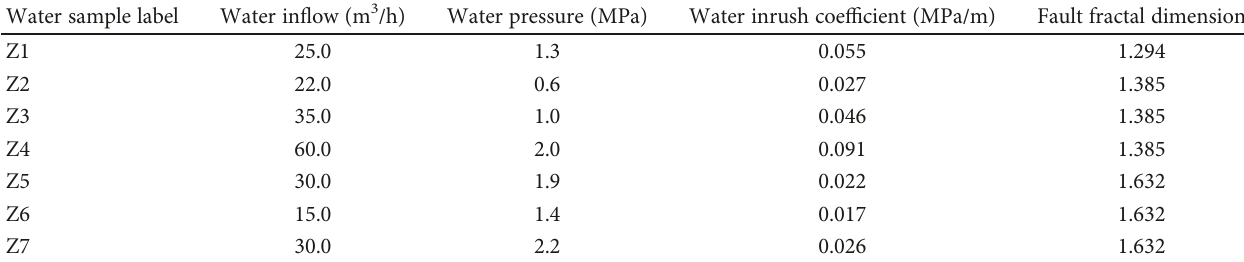
Table 4: Parameters of water sample to be identi fi ed.